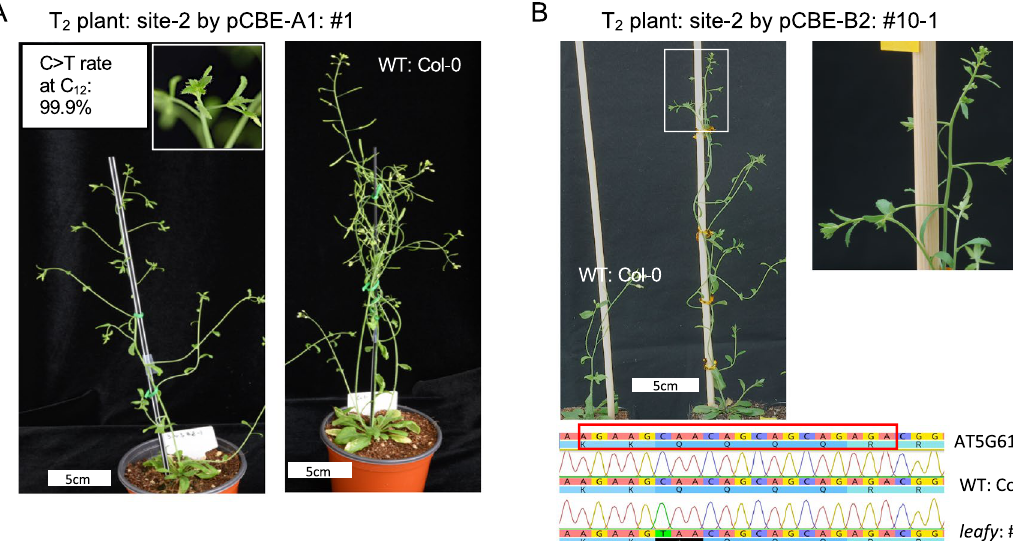
Figure 2. Distinct lfy mutant phenotype in T 2 plants induced by CRISPR/Cas9-mediated cytosine base editing in Arabidopsis . ( A ) A T 2 plant transformed with pCBE-A1 targeting site-2 displaying the lfy mutant phenotype, with the wild-type Col-0 plant for comparison. C-to-T conversion was confirmed for position C 12 , which had a conversion rate of 99.9% as calculated following targeted deep sequencing analysis. ( B ) A T 2 plant transformed with pCBE-B2 targeting site-2 with the Col-0 plant. The meristem region of inlet was magnified next to the whole plant picture. The complete conversion of C-to-T on the position C 6 was presented by Sanger sequencing